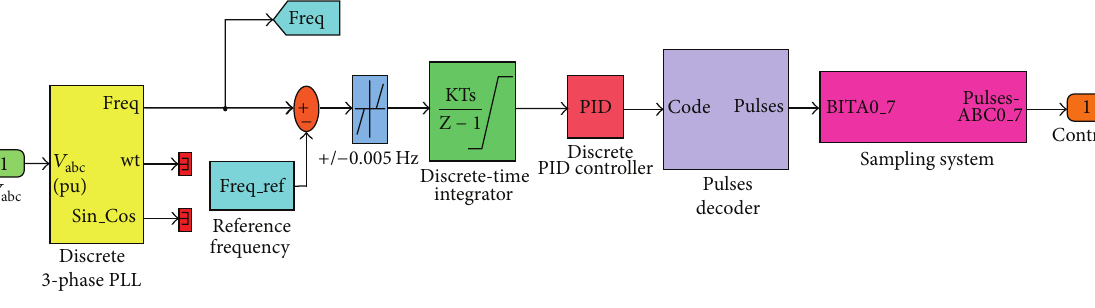
Figure 4: Simulation Block Diagram of Frequency Control.